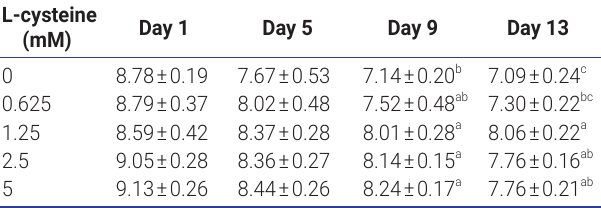
Table 5. Effects of different concentrations of cysteine on sperm beat-cross frequency (BCF, Hz) during the liquid storage L-cysteine (mM)